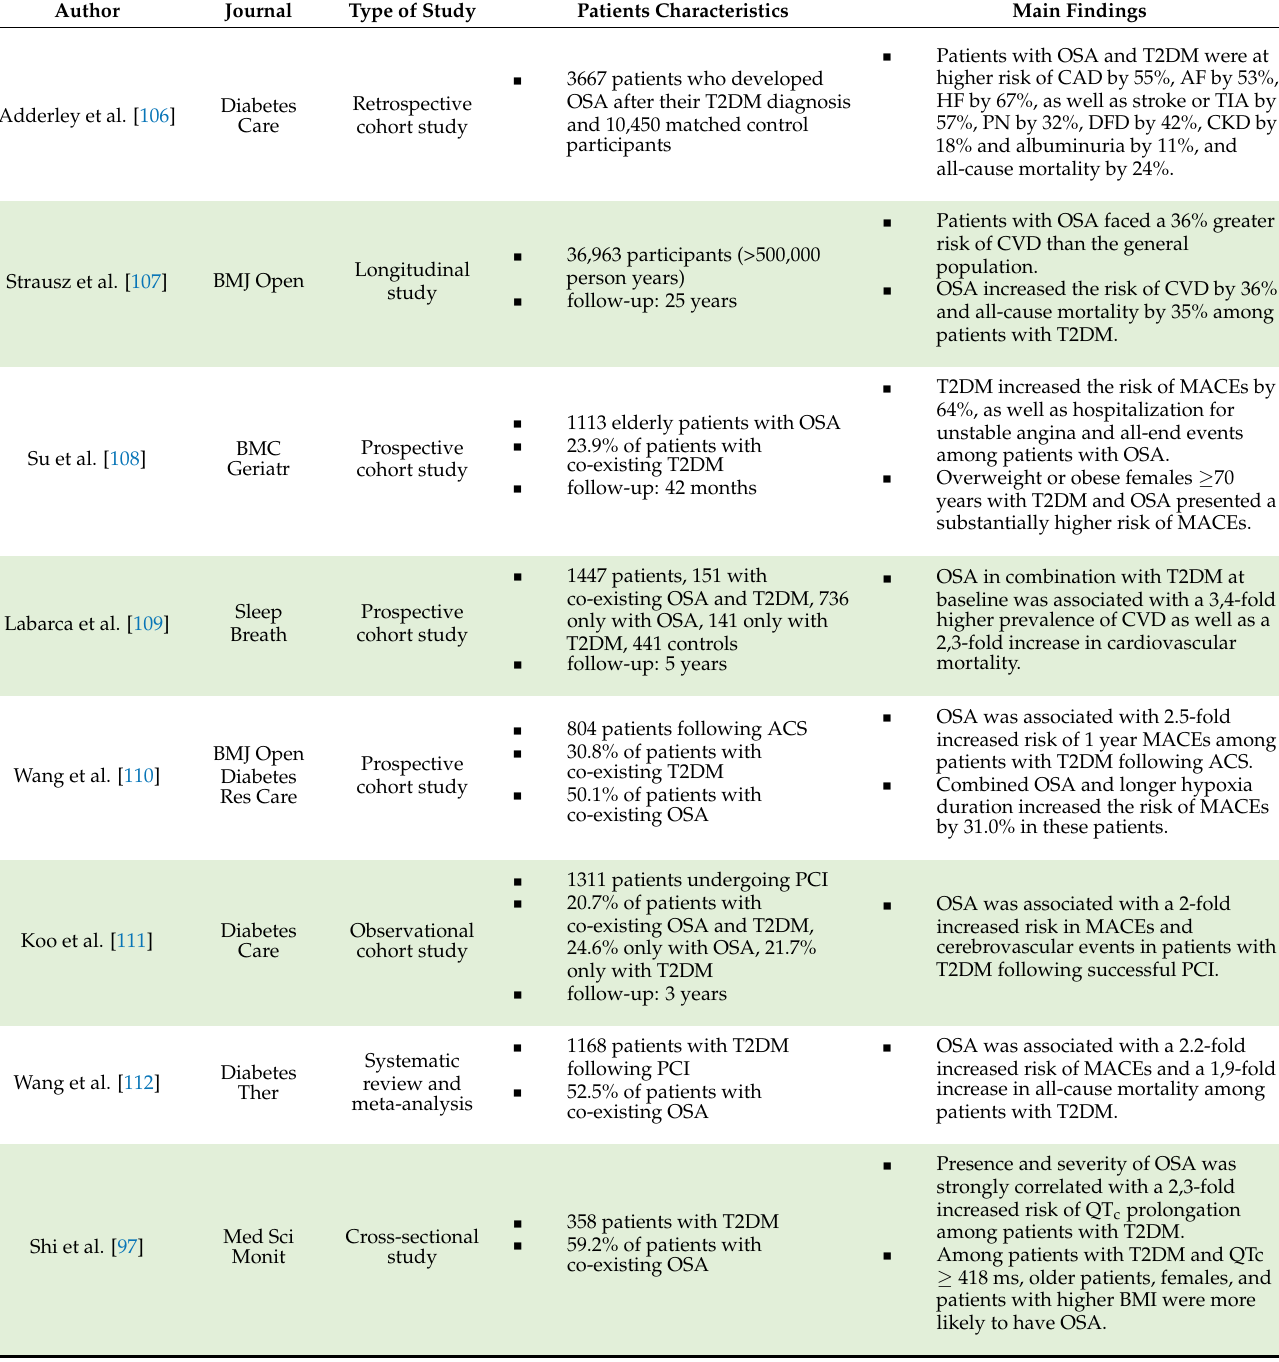
Table 1. Main studies evaluating the CV risk among patients with OSA and prediabetes or T2DM.